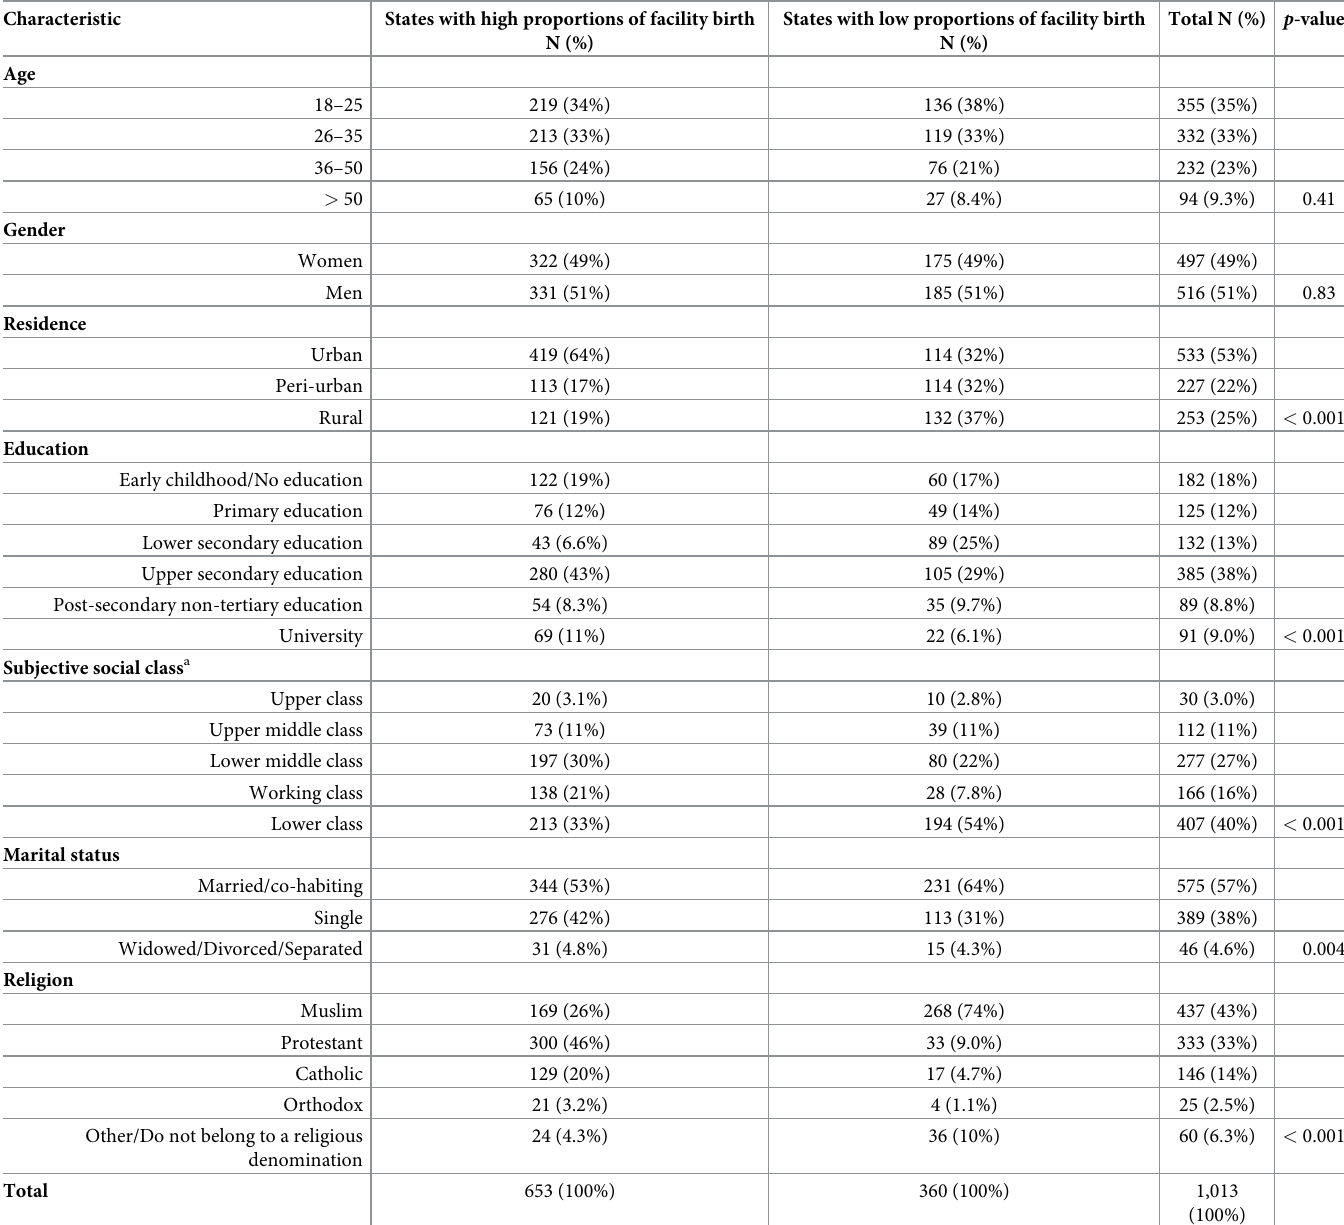
Table 2. Characteristics of participants in the 2018 Nigeria World Values Survey.